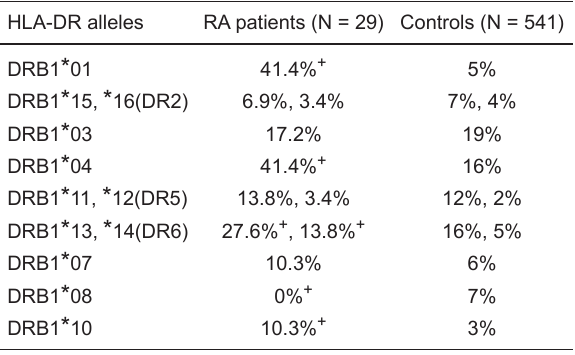
Table 2. Frequency distribution of HLA-DR alleles among rheumatoid arthritis (RA) patients and controls. HLA-DR alleles